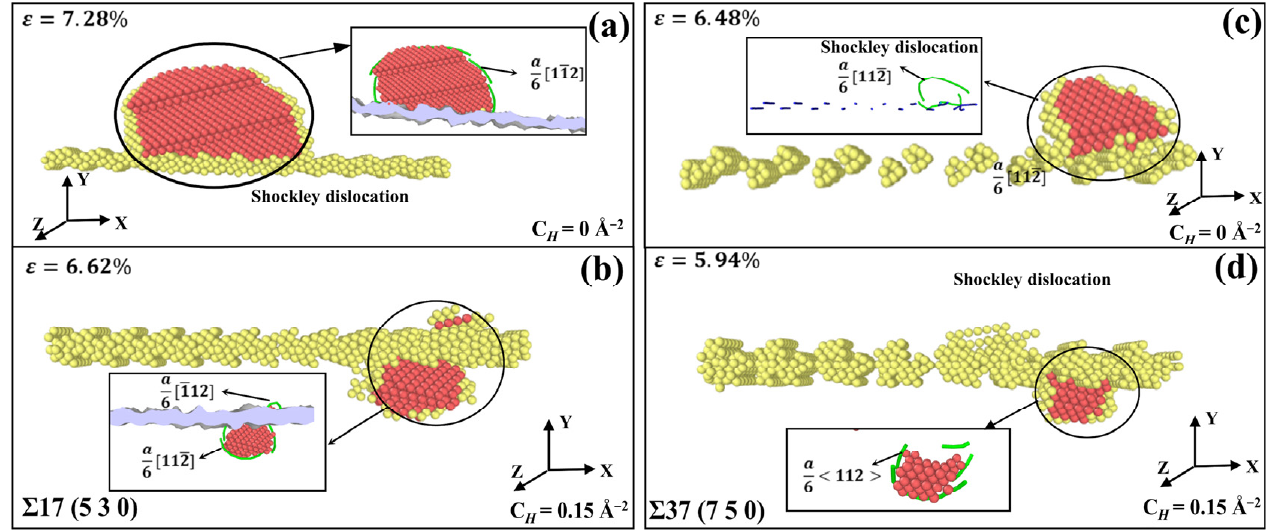
Figure 8. MD snapshots of dislocation nucleation from Ni bicrystal with ( a , b ) Σ 17 (5 3 0) STGB and ( c , d ) Σ 37 (7 5 0) STGB without and with H.